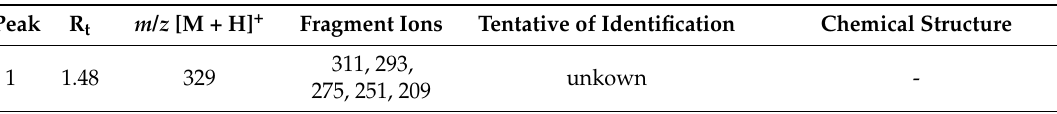
Table 2. Identification of secondary metabolites in Calycophyllum spruceanum water extract by LC MS/MS using ESI.